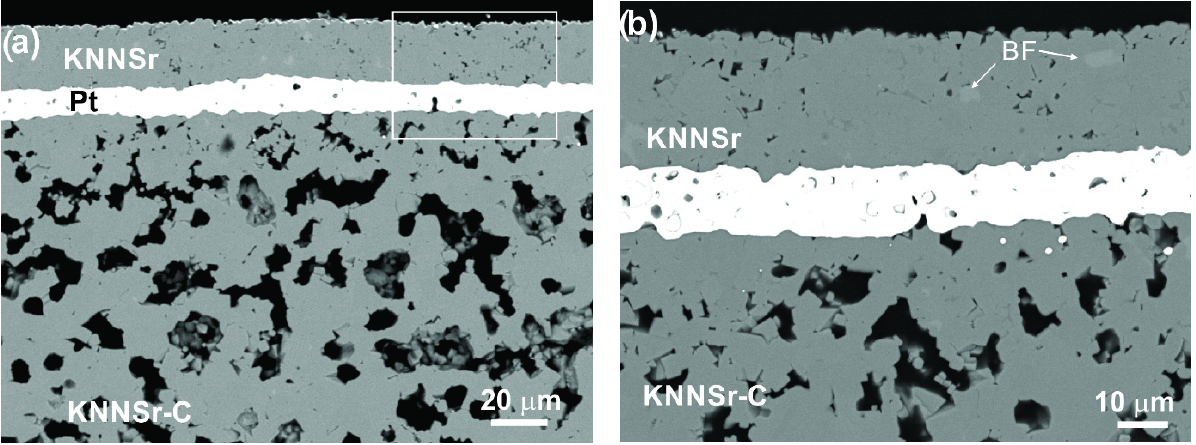
Figure 5. Cross-section SEM/backscattered electron microscopy (BEI) image of KNNSr-T ( a ) and the inset ( b ).